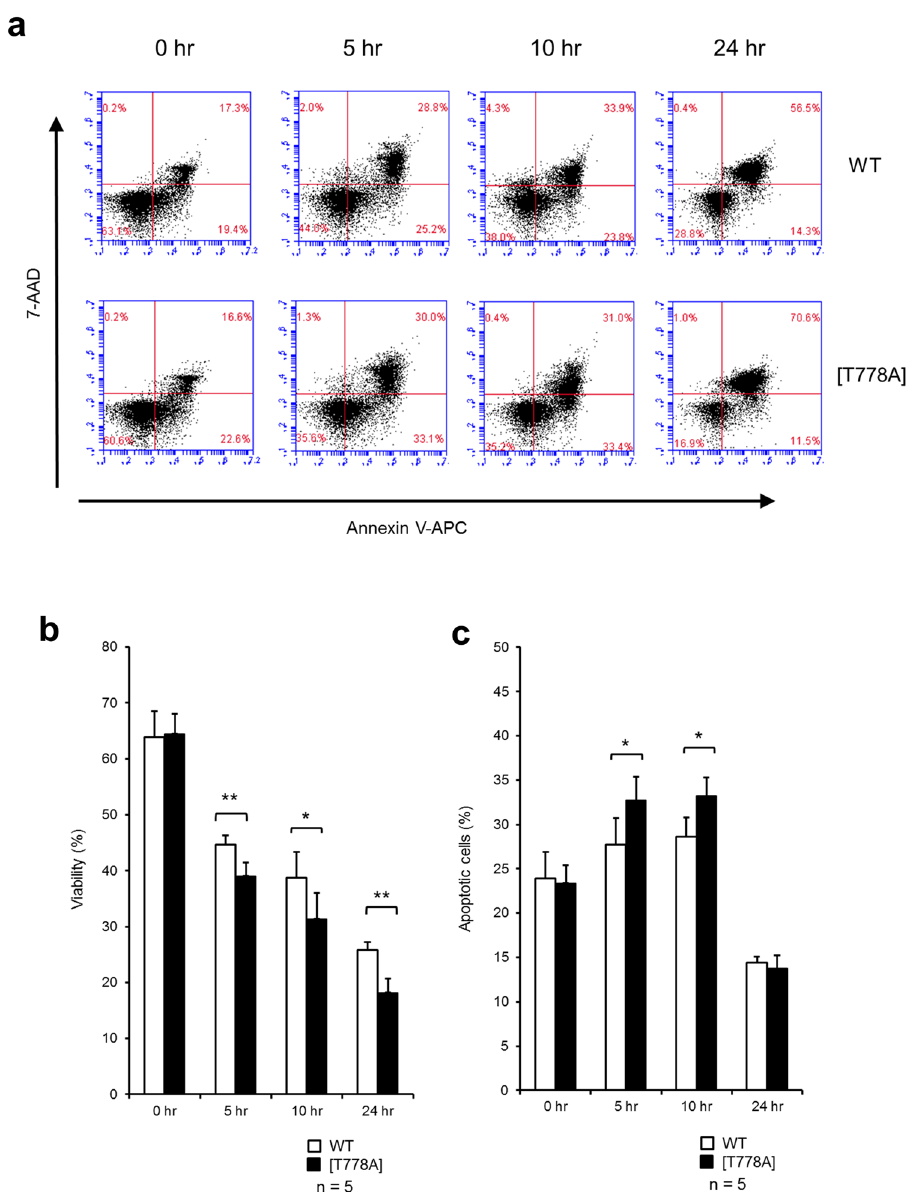
Figure 5. Survival assay of splenic lymphocytes from WT and PKN1[T778A] mice. Viability of lymphocytes were evaluated by flow cytometry with Annexin V-APC and 7-AAD using BD Accuri flow cytometer and Accuri C6 Software. ( a ) Representative dot plots at the indicated time points are shown. ( b ) Viability was evaluated as the percentage of cells that were negative for both Annexin V-APC and 7-AAD. ( c ) The apoptotic cell percentage was quantified from cells that were positive for Annexin V-APC and negative for 7-AAD. Data were analysed with paired t-tests. * P < 0.05. ** P <